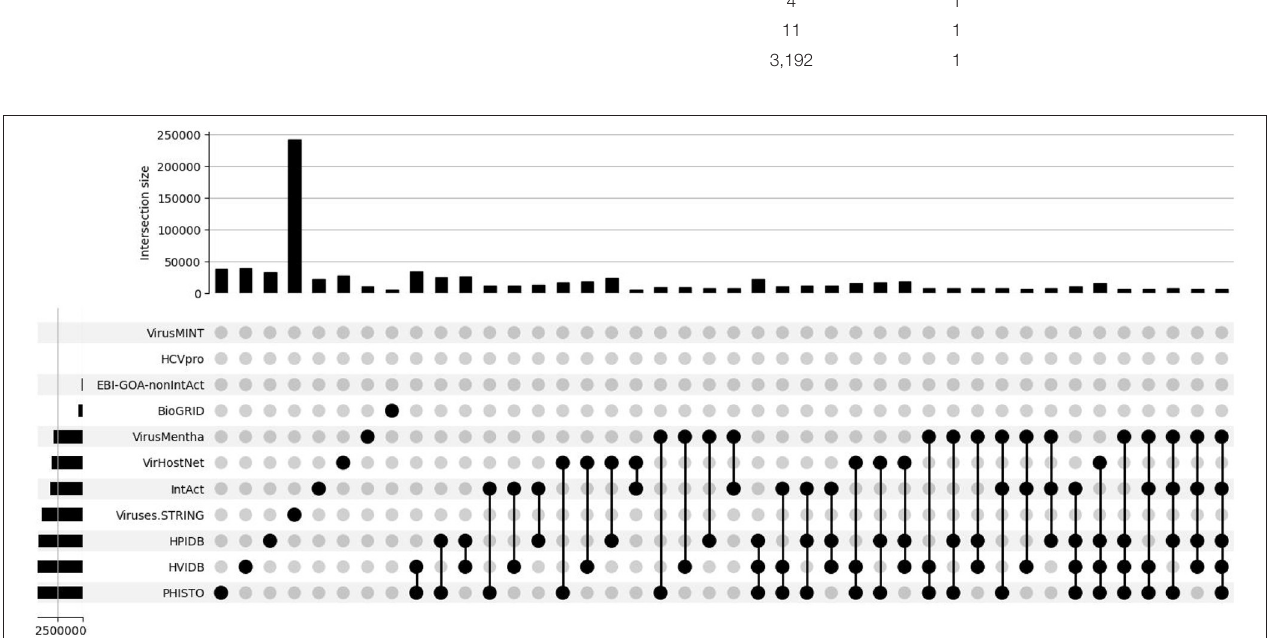
FIGURE 3 | Overlap of the virus-host protein–protein interaction